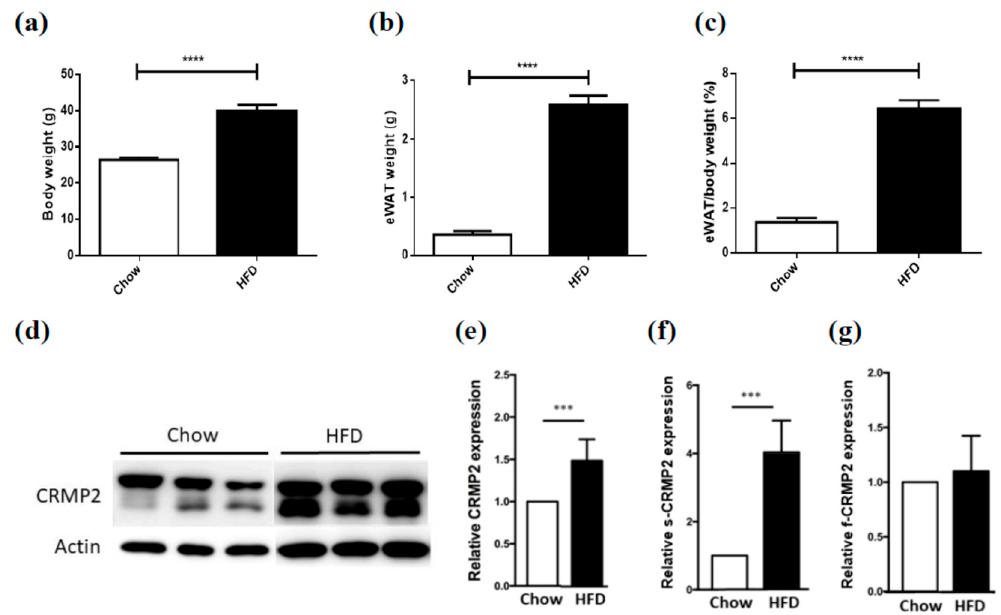
Figure 8. CRMP2 regulates adipocyte differentiation and lipid deposits. ( a – c ) Significant differences of body weights (BW), epididymal white adipose tissue (eWAT) weights and eWAT/ratio between Chow and HFD mice were identified. ( d ) Representative results of Western blot analysis and ( e – g ) quantitative results of CRMP2 expression in epididymal fat tissues obtained from standard Chow diet-feeding WT mice ( n = 5) and HFD obese mice ( n = 5), *** p < 0.001, **** p < 0.0001.